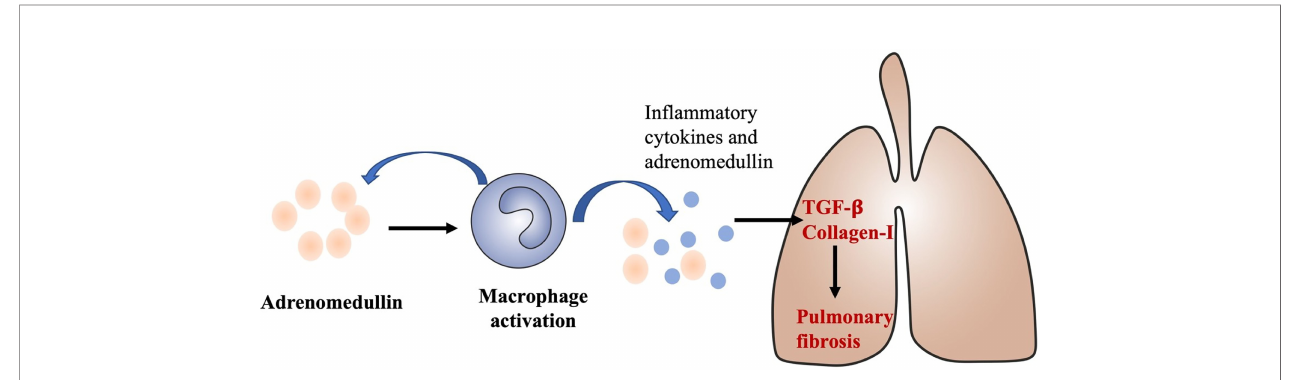
FIGURE 6 | A proposed role of adrenomedullin in the develop and progress of ILD in DM. Adrenomedullin stimulates macrophage activations and activated macrophage could also secrete adrenomedullin and other in fl ammatory cytokines, type I interferon, promote the production of TGF- b , and collagen-I which could contribute to the develop and progress of ILD in DM.